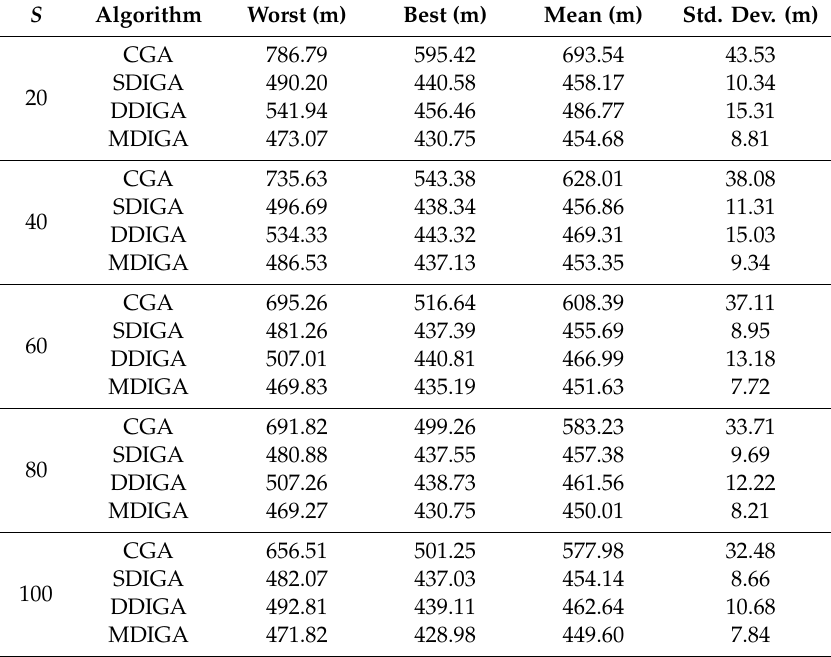
Table 5. Statistical results of optimal path distance in 100 runs with five population